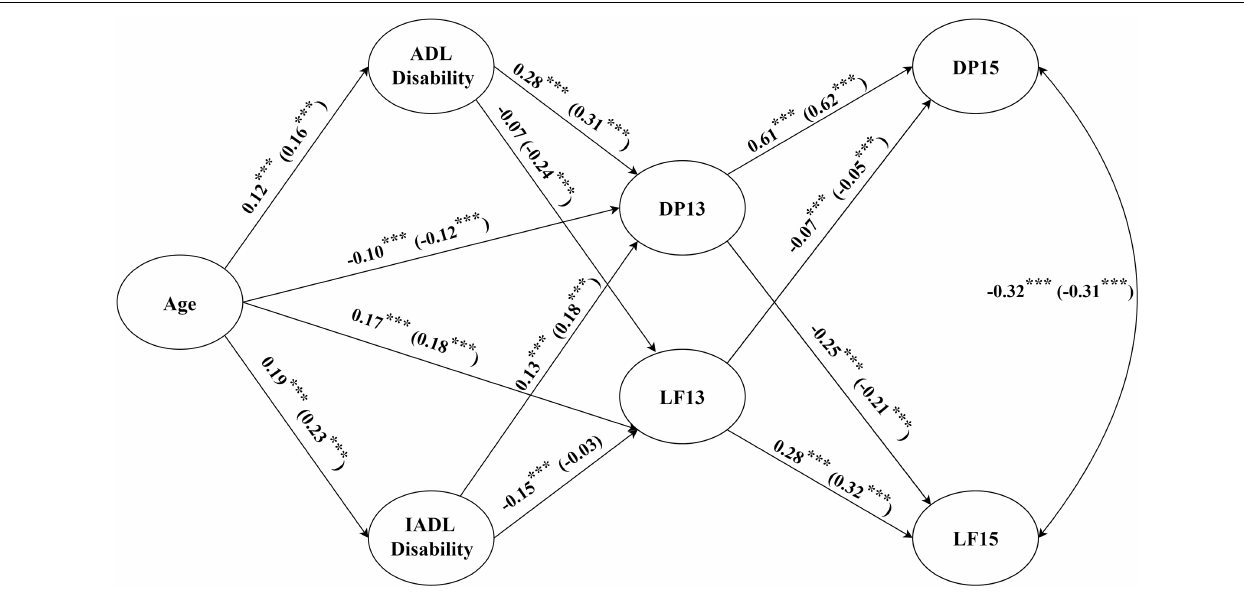
FIGURE 4 | Structural equation modeling for different genders. The coefficients inside the brackets are for women. Significant paths with gender difference according to the multi-group comparison analysis by LISREL: Age → ADL disability ( (cid:49) χ 2 = 4.63, p < 0.05), Age → IADL disability ( (cid:49) χ 2 = 4.31, p < 0.05), Age → DP13 ( χ 2 = 4.25, p < 0.05), Age → LF13 ( (cid:49) χ 2 = 3.99, p < 0.05), IADL disability → LF13 ( (cid:49) χ 2 = 4.43, p < 0.05), DP13 → DP15 ( (cid:49) χ 2 = 4.09, p < 0.05), and DP13 → LF15 ( (cid:49) χ 2 = 4.43, p < 0.05), LF13 → LF15 ( (cid:49) χ 2 = 3.85, p < 0.05). ADL, activities of daily living; IADL, instrumental activities of daily living; DP13, depression in 2013–2014; DP15, depression in 2015–2016; LF13, life satisfaction in 2013–2014; LF15, life satisfaction in 2015–2016. *** p <